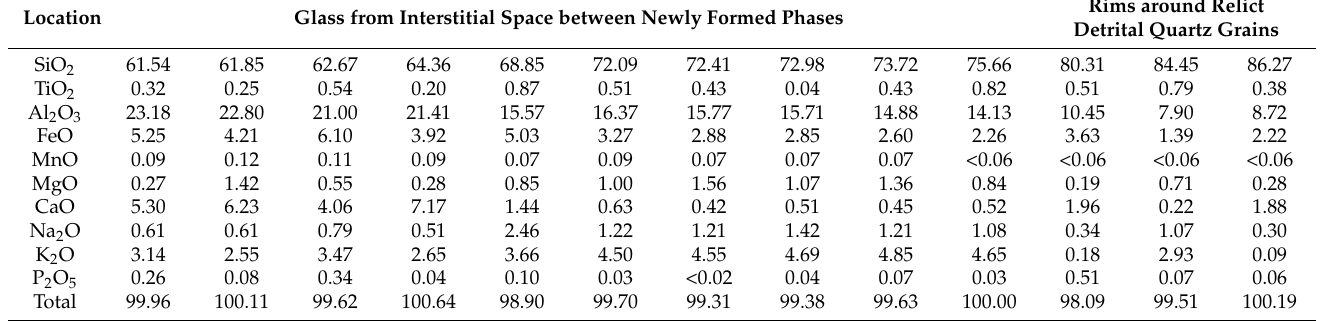
Table 3. Compositions of glass in combustion metamorphic rocks from Karabetova Gora MV (Taman Peninsula). EPMA data (in wt%).